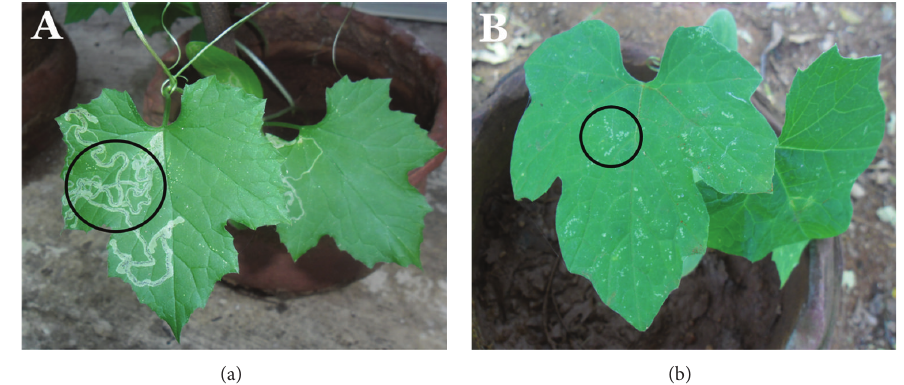
Figure 1: Diseases infected agricultural plant leaves of Abelmoschus esculentus and Citrullus lanatus .